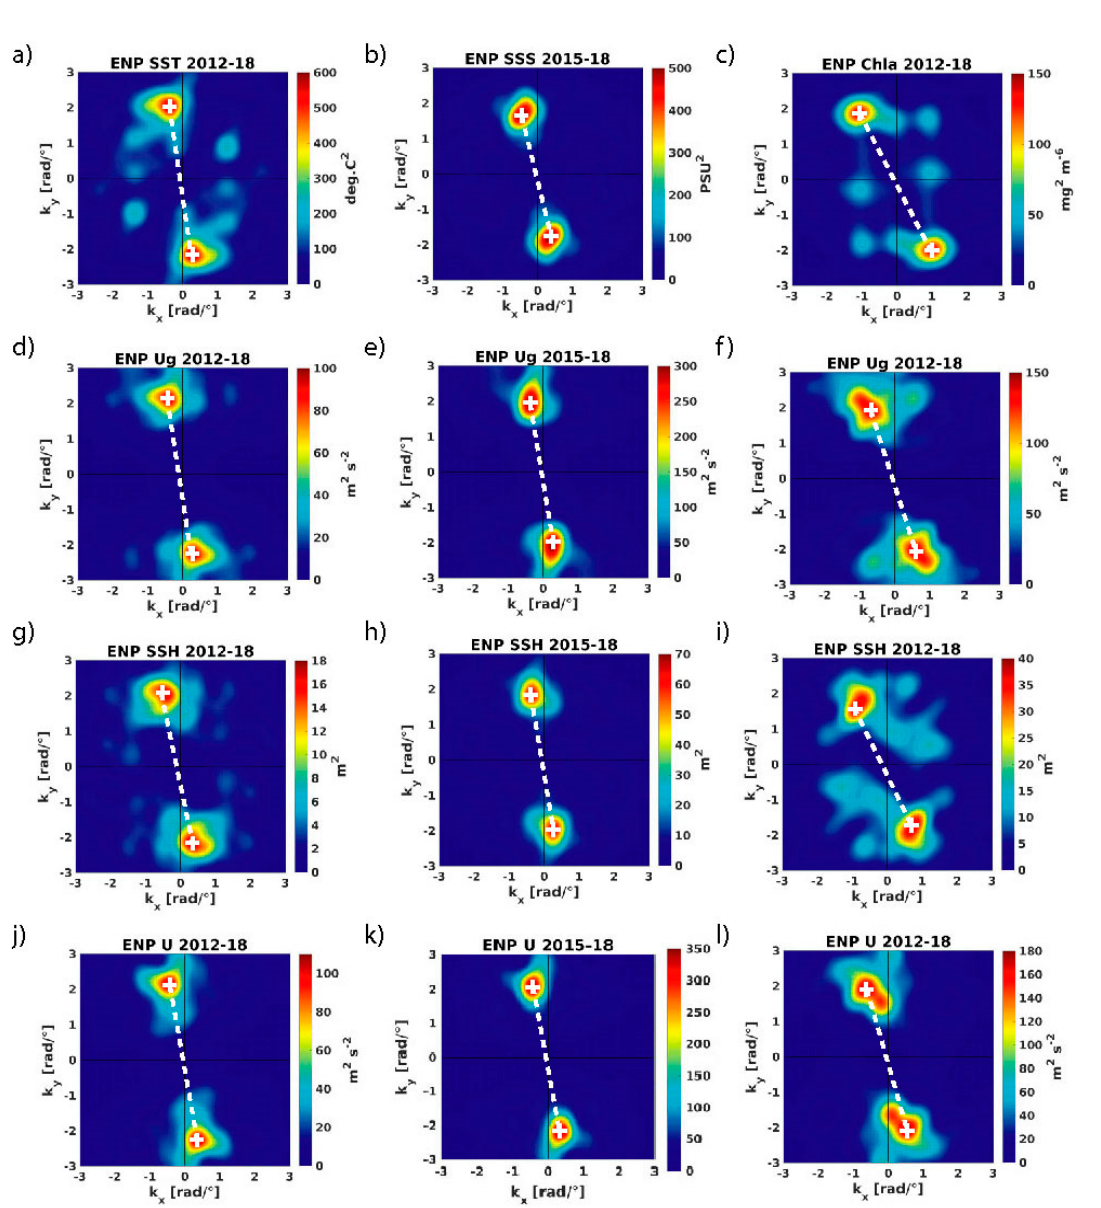
Figure 4. Spatial power spectra of mean spatially high-pass filtered fields in the ENP, computed within the dashed boxes in Figure 2. ( a ) AMSR-2 SST (°C 2 ); ( b ) SMAP SSS (PSU 2 ); ( c ) GlobColour Chl-a (mg 2 m − 6 ); ( d – f ) SSALTO/DUACS U g (m 2 s − 2 ); ( g – i ) SSALTO/DUACS SSH (m 2 ); and ( j–l ) SCUD U (m 2 s − 2 ). The data are averaged over (left and right columns) 2 July 2012–31 December 2018 and (middle column) 4 April 2015–31 December 2018 in (left and middle columns) the offshore region and (right column) the coastal transition zone. The white crosses indicate the locations of the symmetric maxima, joined by the dashed lines indicating the direction of the dominant wave